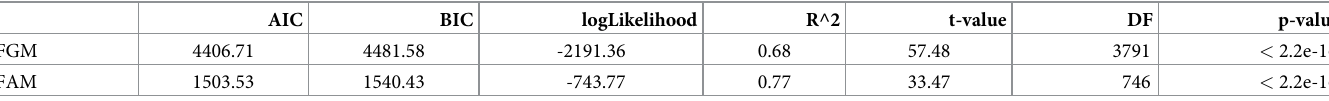
Table 3. Goodness of fit statistics for the two